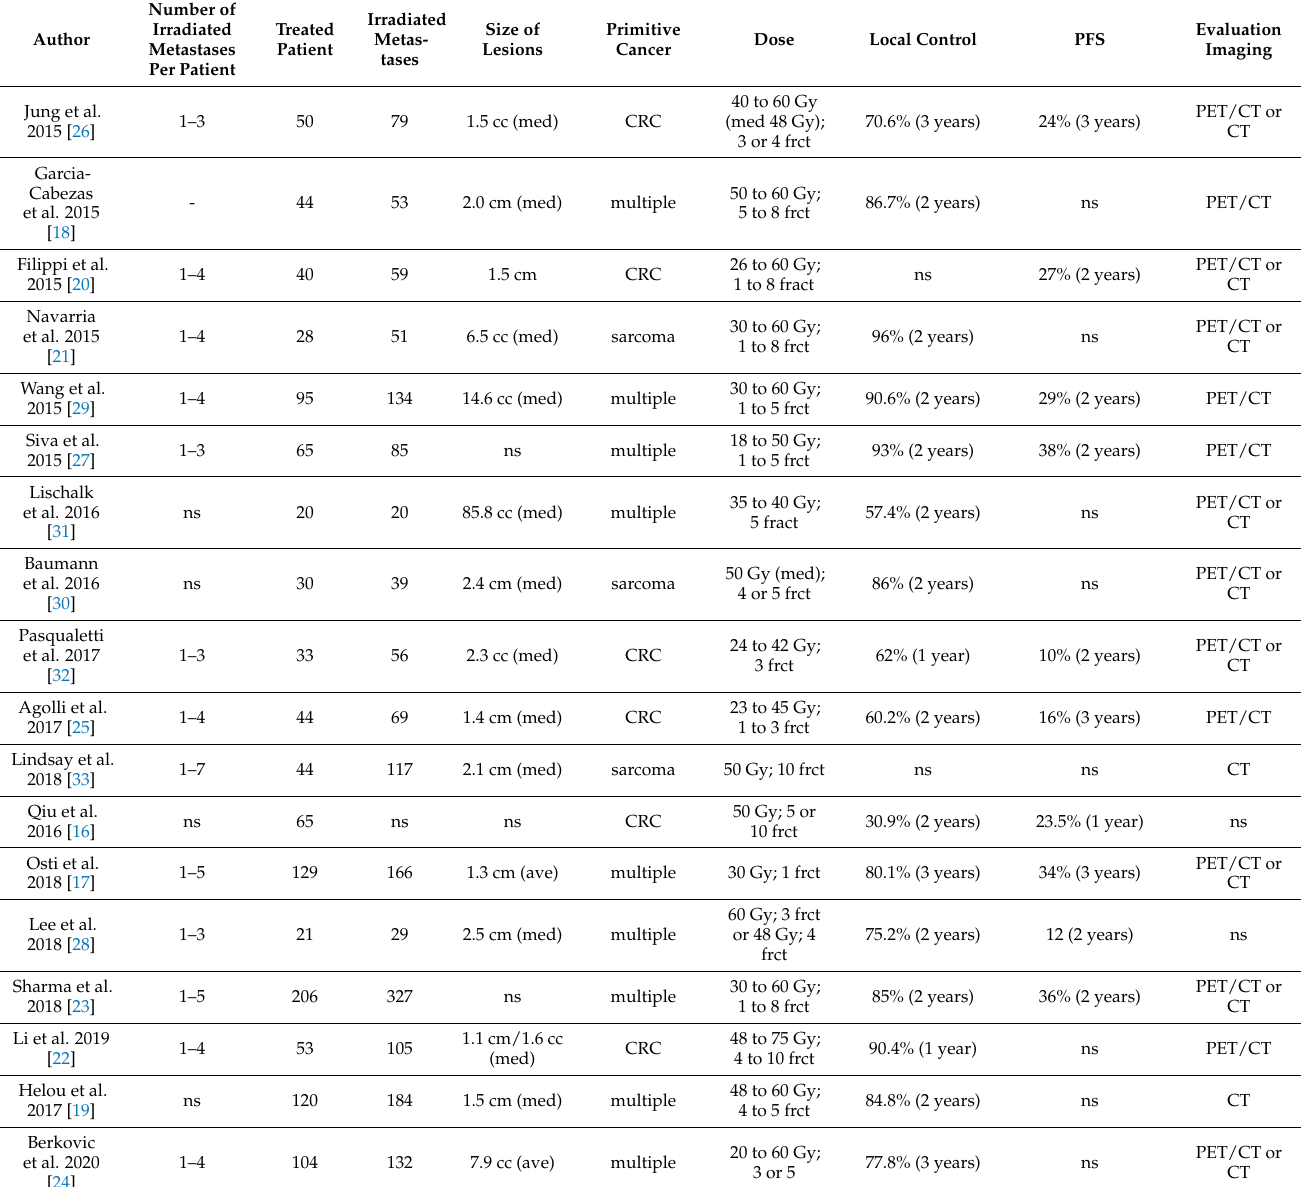
Table 1. Characteristics and outcome of lung SBRT in the 18